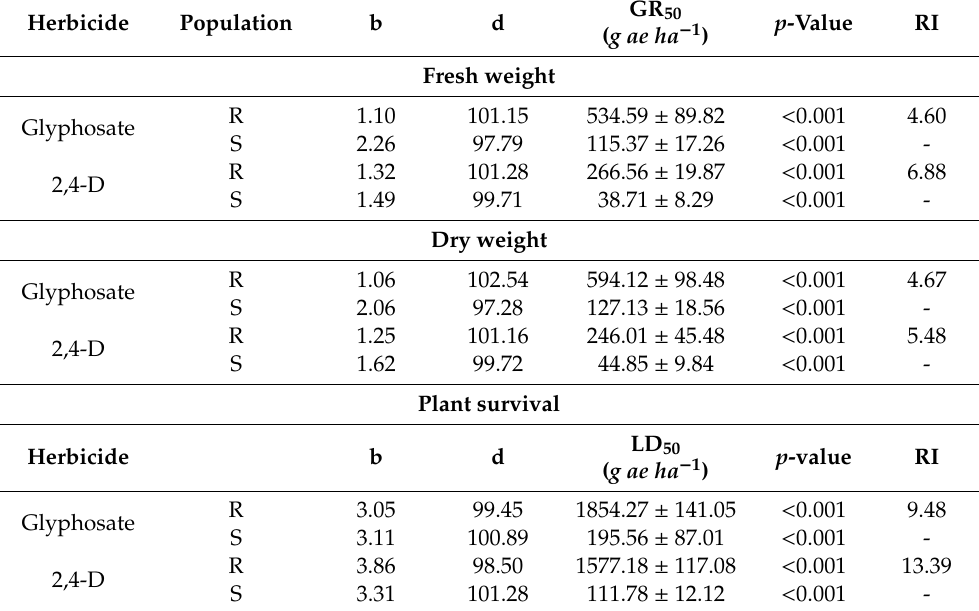
Figure 2. Shikimic acid accumulation of susceptible (S) and resistant (R) C. acanthoides plants at different glyphosate concentrations. Vertical bars represent the standard error of the mean ( n = 3 per glyphosate concentration).